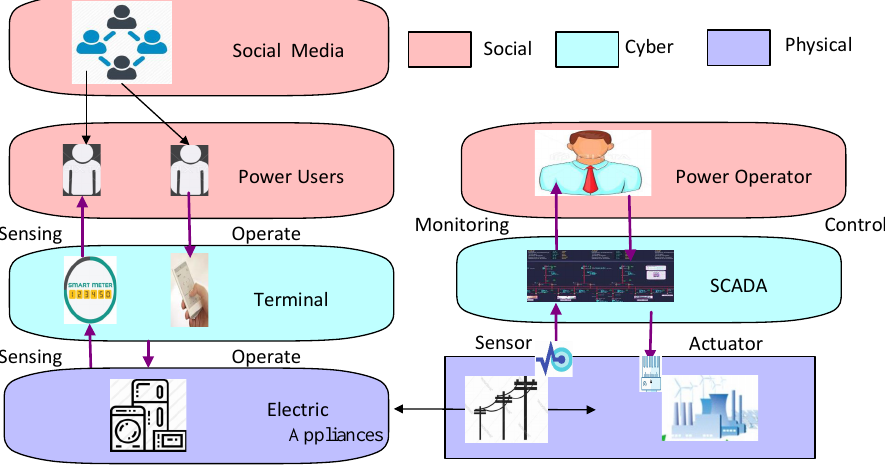
Figure 5. Cyber-Physical System (CPS) model with social